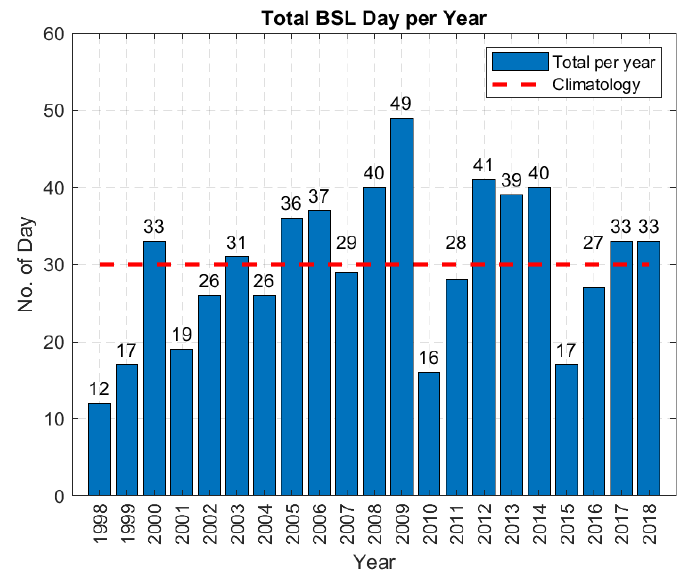
Figure 4. Total annual frequency (day) of BSL from the year 1998 to 2018.